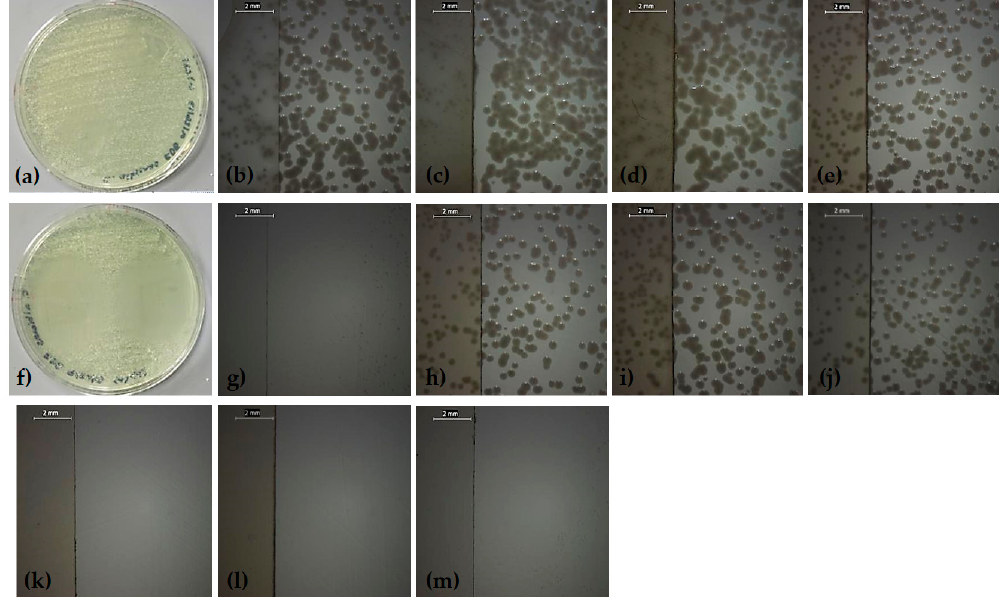
Figure 5. Modified disk diffusion images of samples plated with C. albicans : ( a ) macroscopic view of negative control, ( b ) negative control, ( c ) polyvinylpyrrolidone, ( d ) polyvinylpyrrolidone–quercetin dihydrate, ( e ) polyvinylpyrrolidone–resveratrol, ( f ) macroscopic view of positive control, ( g ) positive control, ( h ) polyvinylpyrrolidone–quercetin dihydrate–amphotericin B, ( i ) polyvinylpyrrolidone–resveratrol–amphotericin B, ( j ) polyvinylpyrrolidone–amphotericin B, ( k ) polyvinylpyrrolidone–voriconazole, ( l ) polyvinylpyrrolidone–quercetin dihydrate–voriconazole, and ( m ) polyvinylpyrrolidone–resveratrol–voriconazole.